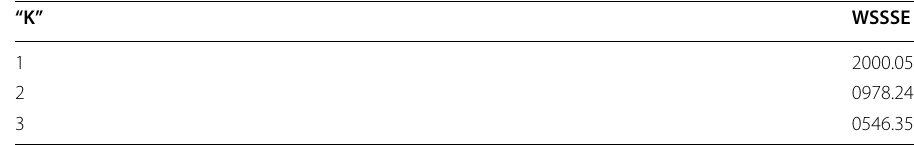
Table 11 Value of WSSSE of different value of “K”